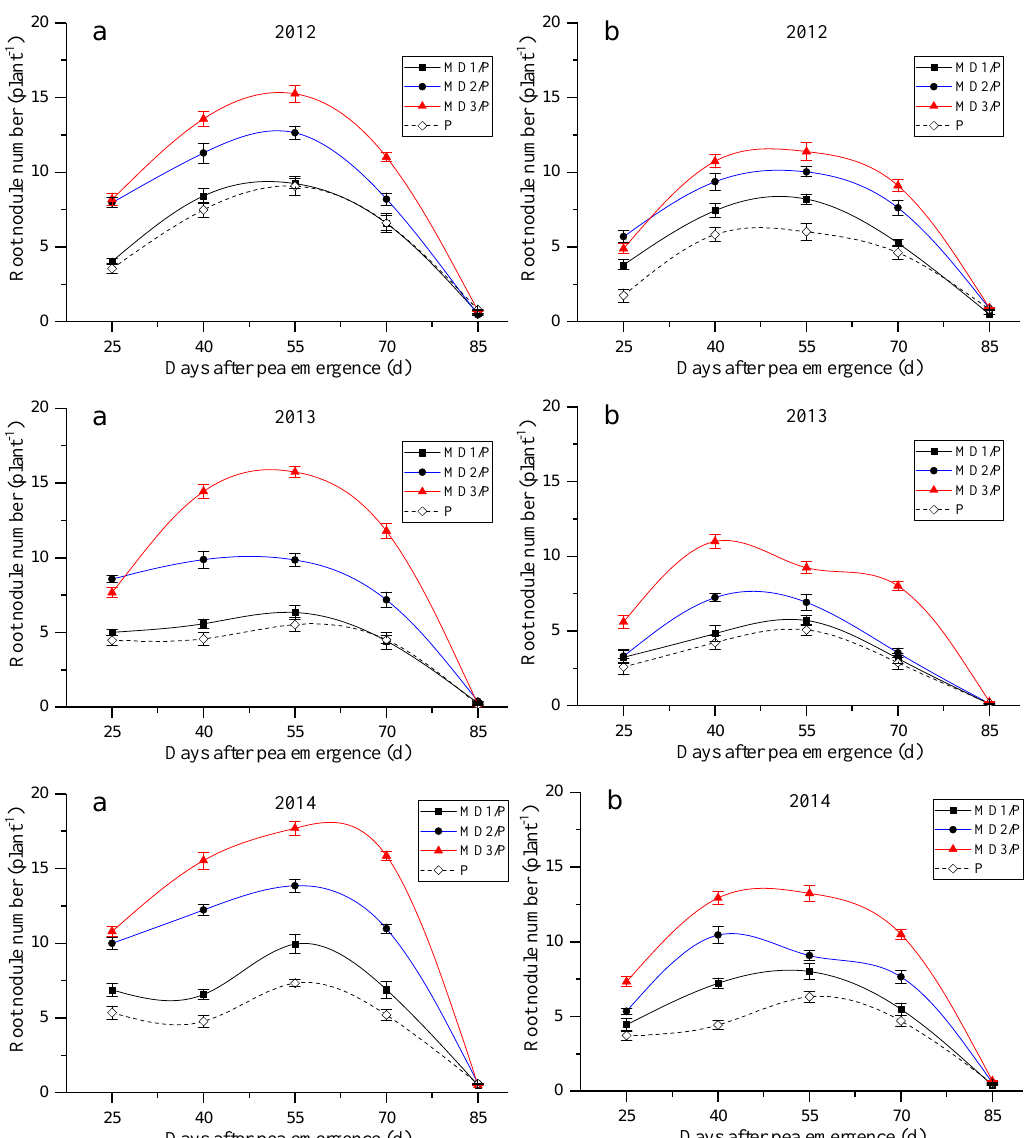
Figure 2. Root nodulation of pea from branching to maturity in pea monoculture and maize / pea intercropping in the Hexi Corridor of northwestern China from 2012 to 2014. Monoculture (P) and intercropped pea (MD1 / P, MD2 / P, and MD3 / P for di ff erent intercropped maize densities) were either unfertilized ( a ) or received 135 kg N ha − 1 at the co-growth period of pea and maize ( b ). Details of the maize / pea intercropping treatments are provided in Table 1. Data points are the mean with standard error bars ( n =